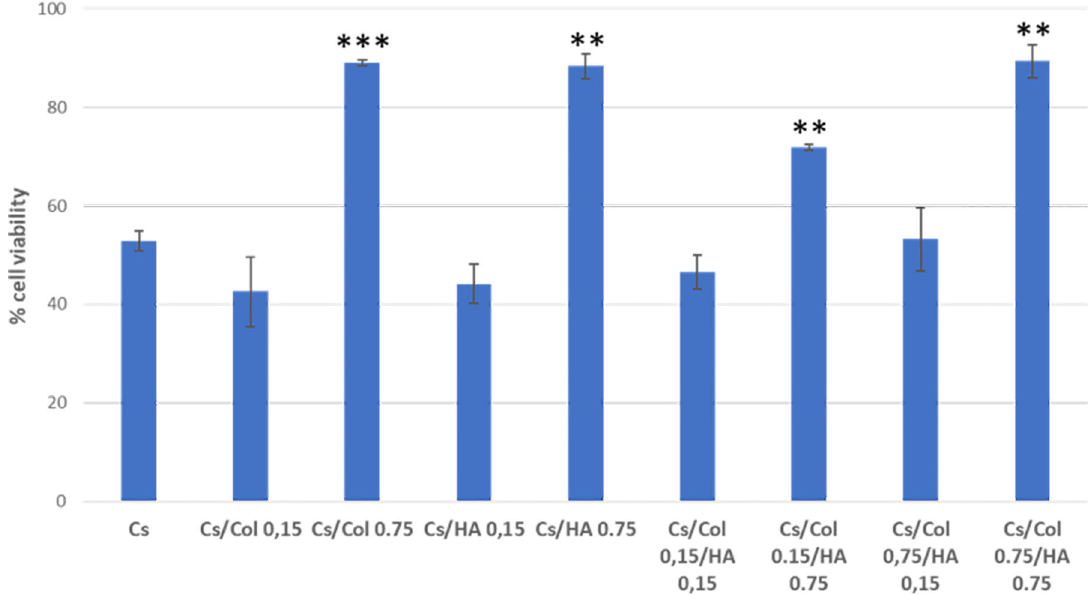
Fig. 8 Cell viability percentage of human buccal fat pad mesenchymal stromal cells (hBFP-MSCs). Signi fi cant value is represented as * p < 0.05, ** p < 0.01, *** p < 0.005 comparing with the Cs membrane (control). N =